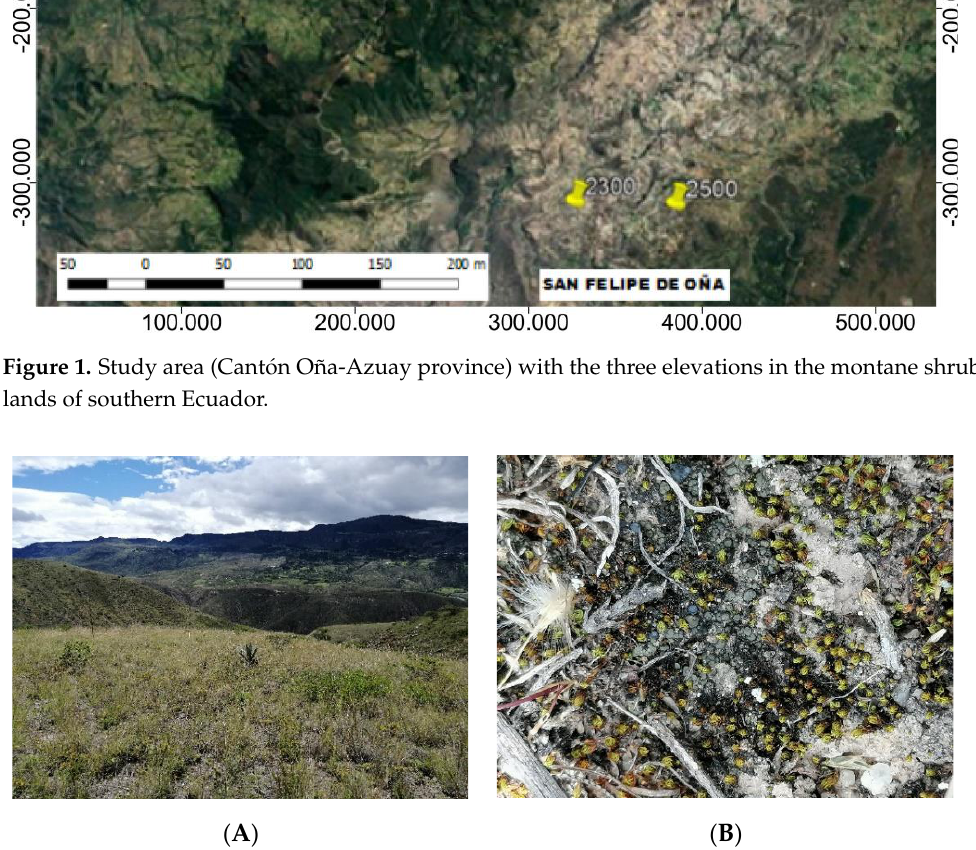
Figure 2. ( A ). The montane shrublands of southern Ecuador; ( B ). Mixed biological soil crust (lichen- dominated and bryophyte-dominated BSC).